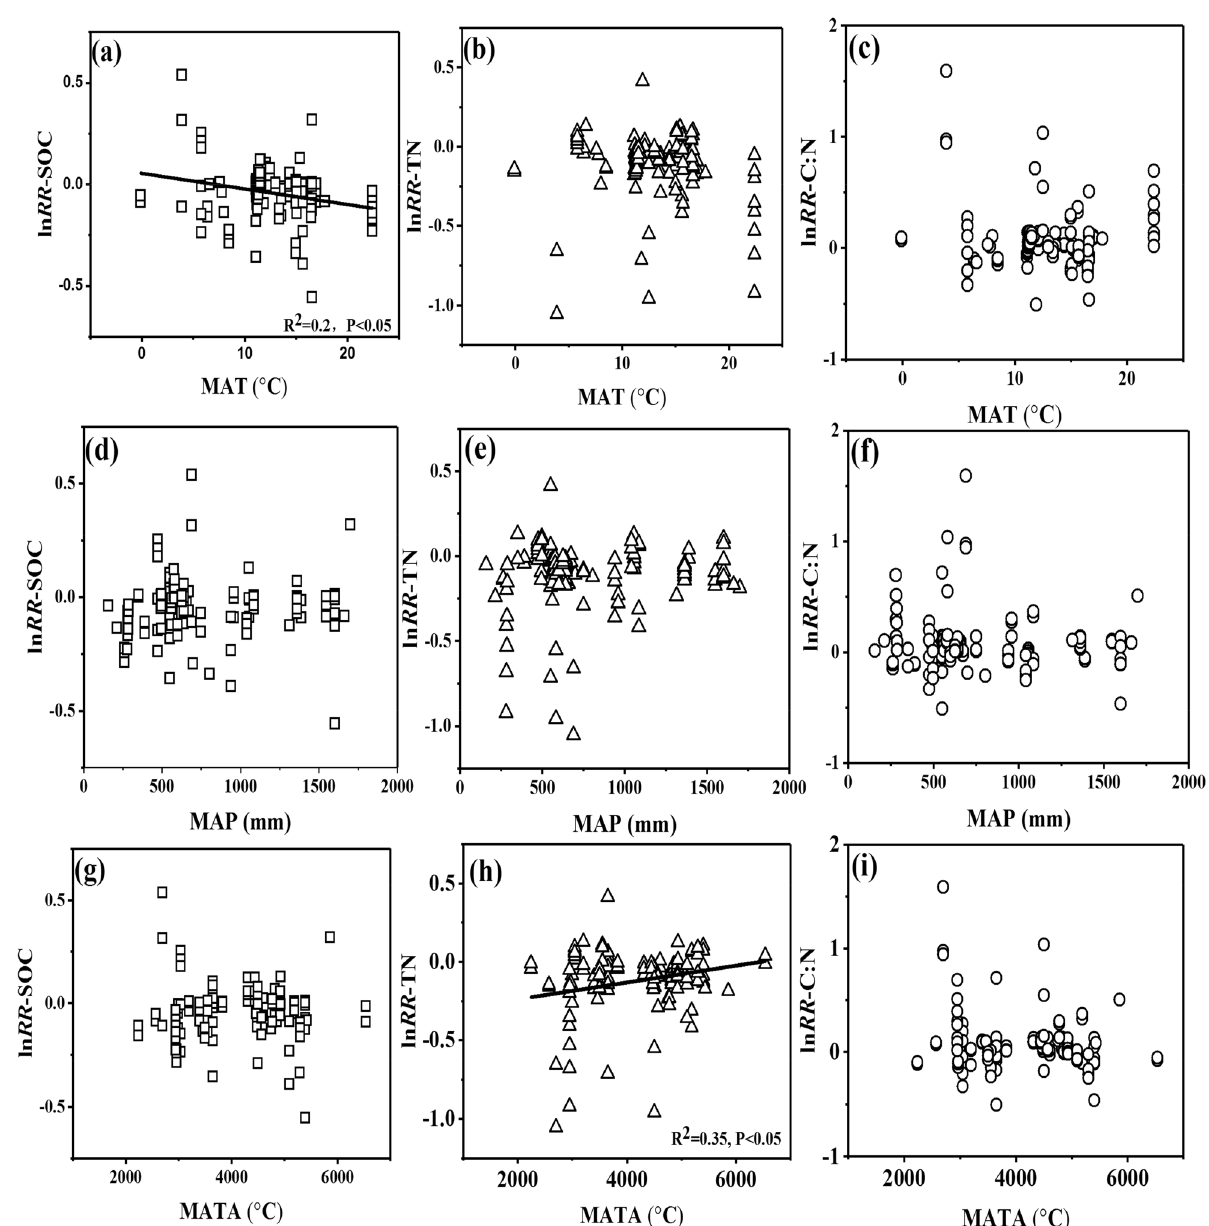
Figure 3. Relationship between mean annual temperature (MAT), mean annual precipitation (MAP), accumulated temperature above 10 ℃ (MATA) and the natural logarithm of the response ratio (lnRR) of soil organic carbon (SOC), total nitrogen (TN), and the ratio of SOC to TN (C:N). The black solid line shows the relationship between the ln RR of SOC, TN, C:N and environmental variables of all database of chemical nitrogen fertilizers without organic fertilizers